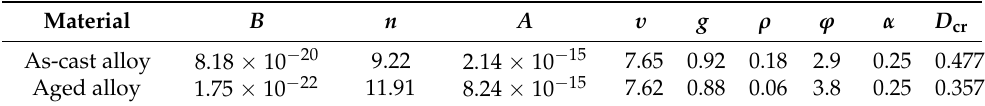
Table 4. Material constants in the damage constitutive equations for HP40Nb alloy at 950 ◦ C. Material B n As-cast